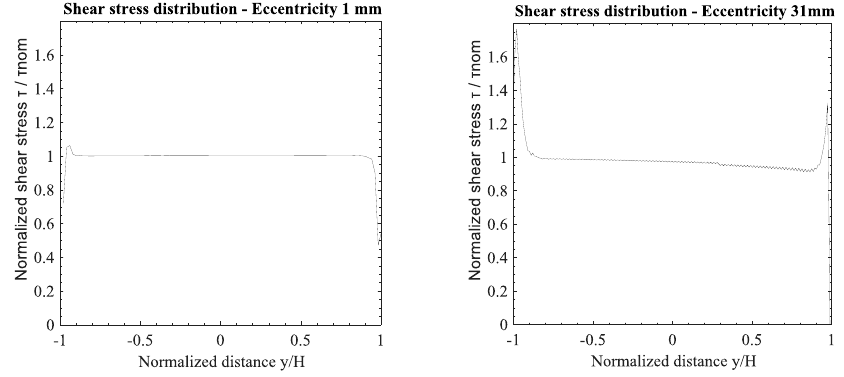
Fig. 16 Shear stress distribution in the adhesive at varying load